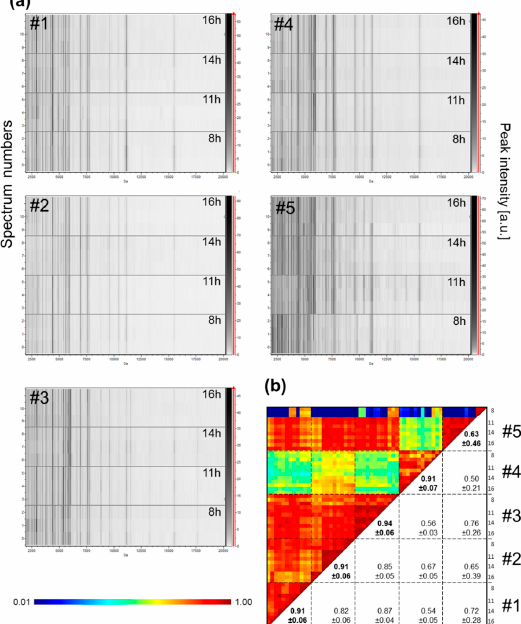
Figure 6. Evolution of MS profiles from kinetic collection of saliva in the same day from healthcare workers. ( a ) Gel view of saliva MS spectra from five distinct individuals. The four collection time points per individual during the same day are indicated in the right part of the gel view. The four replicates loaded on the MS plate for each individual per time point are presented. ( b ) Composite correlation index (CCI) matrix representing the levels of MS spectra reproducibility between collec- tion time points per individual. The values correspond to the mean coefficient correlation and re- spective standard deviations obtained for paired condition comparisons. CCI are expressed as the mean ± standard deviation. #1 to #5: healthcare workers. 3.7. Heterogeneity of Saliva MS Profiles among Healthy Individuals Now that all the analysis and collection parameters allow reliable profiles to be ob- tained, it is possible to extend the cohort of individuals and compare their profiles. The saliva MS profile of 12 healthcare workers was measured. The comparison of the profiles indicates that although several MS peaks were shared, MS profiles appeared to be rather singulars (Figure 7a). The very low CCI values obtained by pairwise comparisons of some individuals, ranging from 0.02 ± 0.00 (mean ± SD) to 0.88 ± 0.03, confirmed the high inter- individual heterogeneity of saliva MS profiles (Figure 7b).